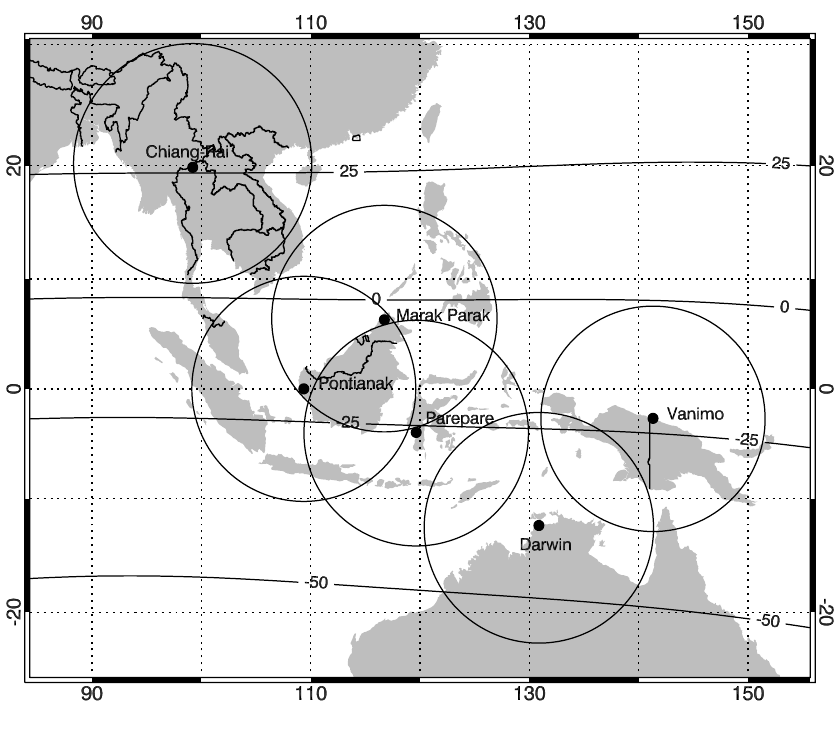
Fig. 1. Locations of GPS receiver network stations. The coverage circles about each station have a radius of 1140km, corresponding to an elevation of 15 ◦ and an ionospheric pierce point altitude of 400km. Also shown are the magnetic equator and the lines of magnetic dip